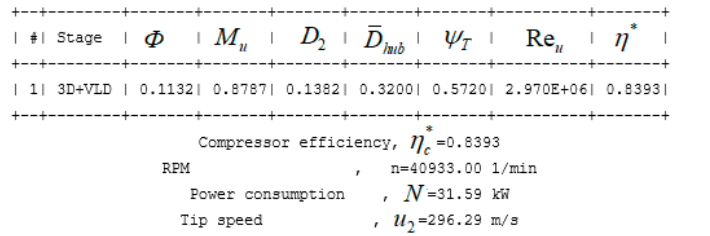
Figure 2. PDCC-G8E program. Variant calculation of the TKR 140E compressor.